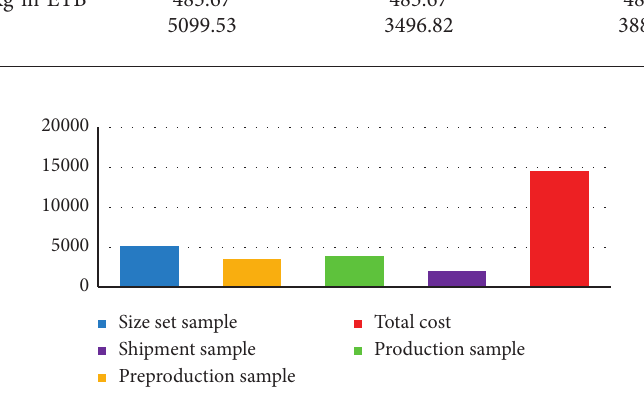
Figure 6: Sample approval cost for export